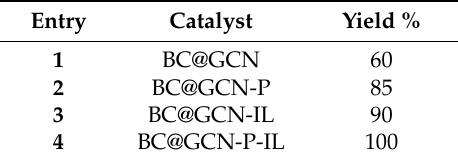
Table 4. The comparison of the efficiency of BC@GCN-P-IL with control samples for model Knoevenagel condensation reaction (reaction of malononitrile and benzaldehyde) under optimum condition.